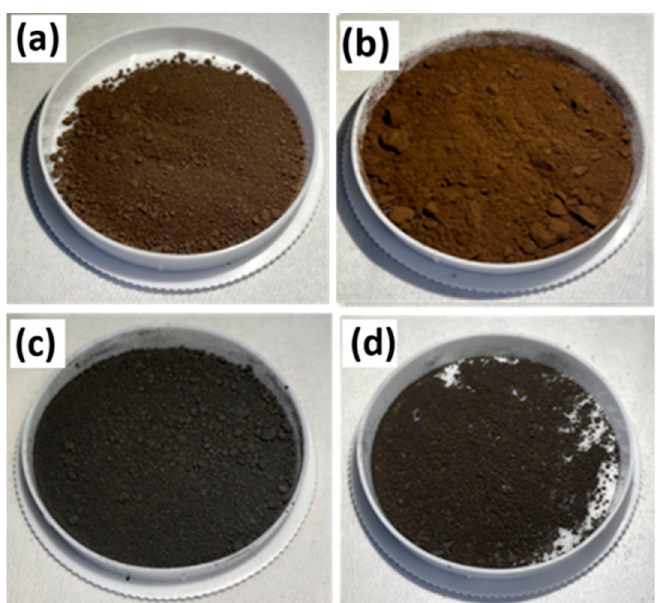
Figure 2. Photographs of ( a ) pristine silicon flakes and silicon flakes with ( b ) RF carbon coatings; ( c ) SiC; and ( d ) combined SiC and RF carbon coatings.